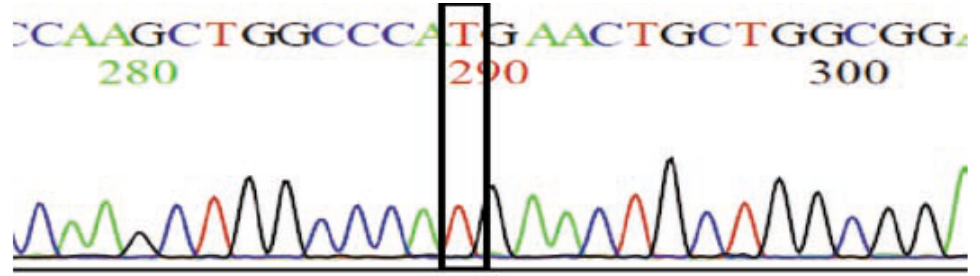
Fig. 3 Chromatogram of the sequenced